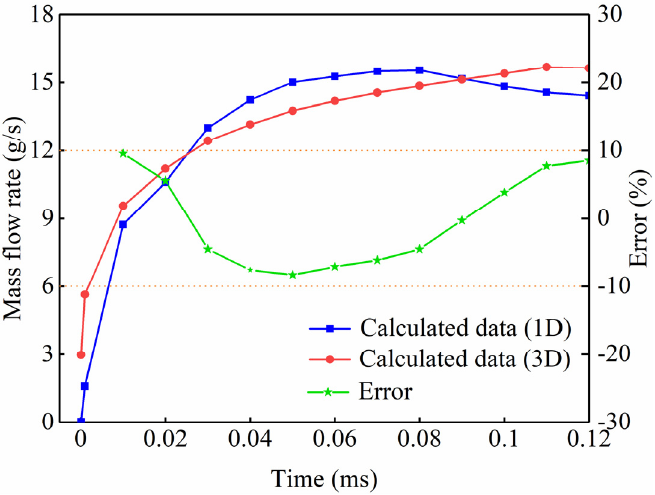
Figure 4. Comparison of mass flow rates for outflowing control orifice between 1D and 3D.